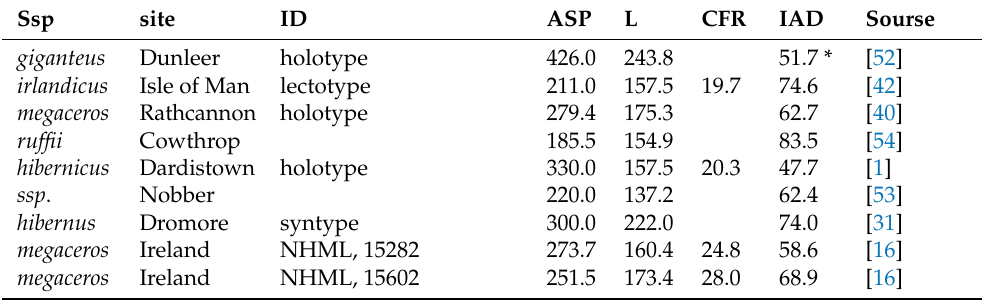
Table 1. Main measurements (cm) of antlers of Megaloceros giganteus and the index of antler diver- gence (antler length/span of antlers × 100%). Abbreviations: Ssp, subspecies; ID, taxonomic status or collection number; L, antler length; ASP, span of antlers; CFR, beam circumference above the basal tine; IAD, index of antler